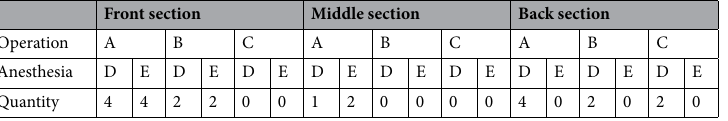
Table 4. Anesthesia methods and the location of secondary epidermoid cysts of the penis. A: Manual circumcision, B: Ligature circumcision, C: Stapler circumcision, D: Penis root injection anesthesia, E: Lidocaine ointment anesthesia. The penis is divided into three segments, and statistics show that the anterior segment (near the glans penis), the middle segment, and the posterior segment (near the abdomen) account for 52.2%, 13.0%, and 34.8%, respectively. When the secondary epidermoid cysts of the penis occurs in the posterior segment, the anesthesia method is injection anesthesia at the base of the penis.